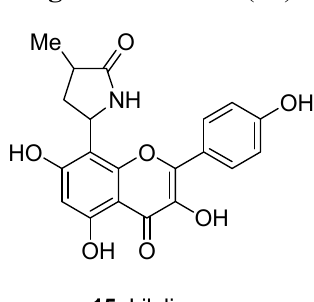
Figure 7. Lilaline ( 15